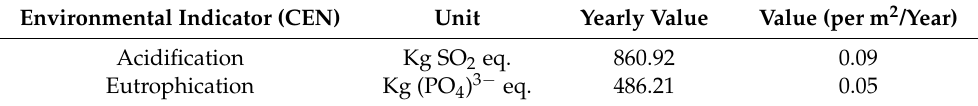
Table 1. Concentration of Acidification and Eutrophication in the reference the neighborhood.